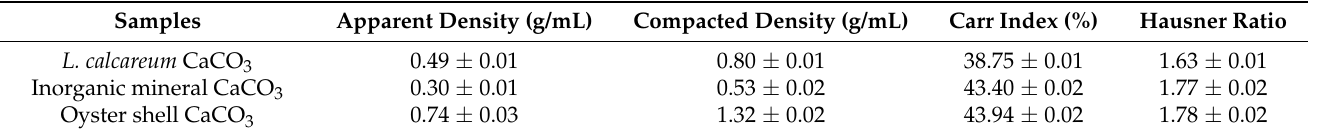
Table 1. Flow properties of CaCO 3 samples: apparent density, compacted density, Carr index and Hausner ratio of Lithothamnium calcareum , inorganic mineral and oyster shell CaCO 3 and ± range (n = 3). Samples